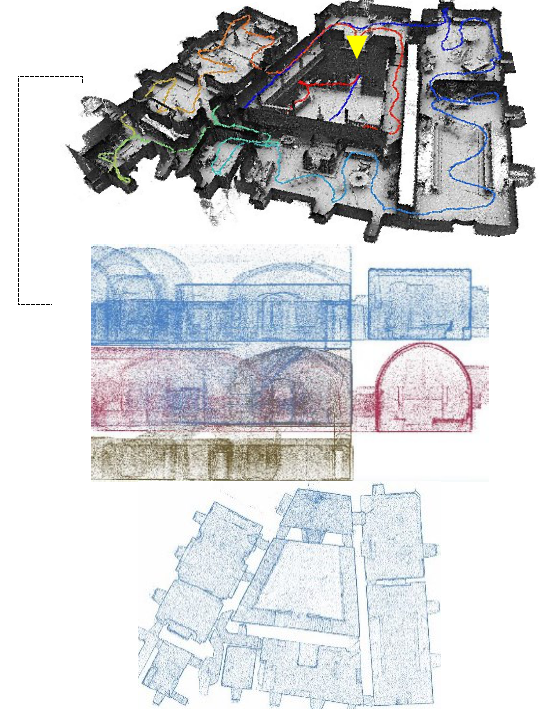
Figure 11. The side-view of the ZEB mapping along the three floors of the Rocca apartments (centre), and planar (down) and 3D view of the first floor (top), and its time-marked trajectory. Starting point at yellow arrow.